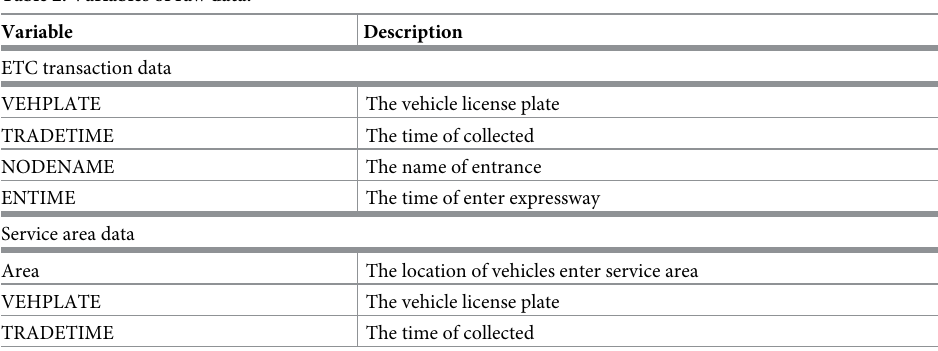
Table 2. Variables of raw